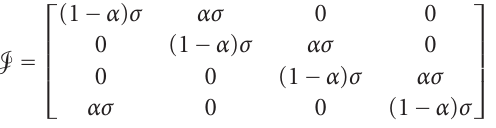
Figure 3.1 illustrates the distributions of types of unstable fixed